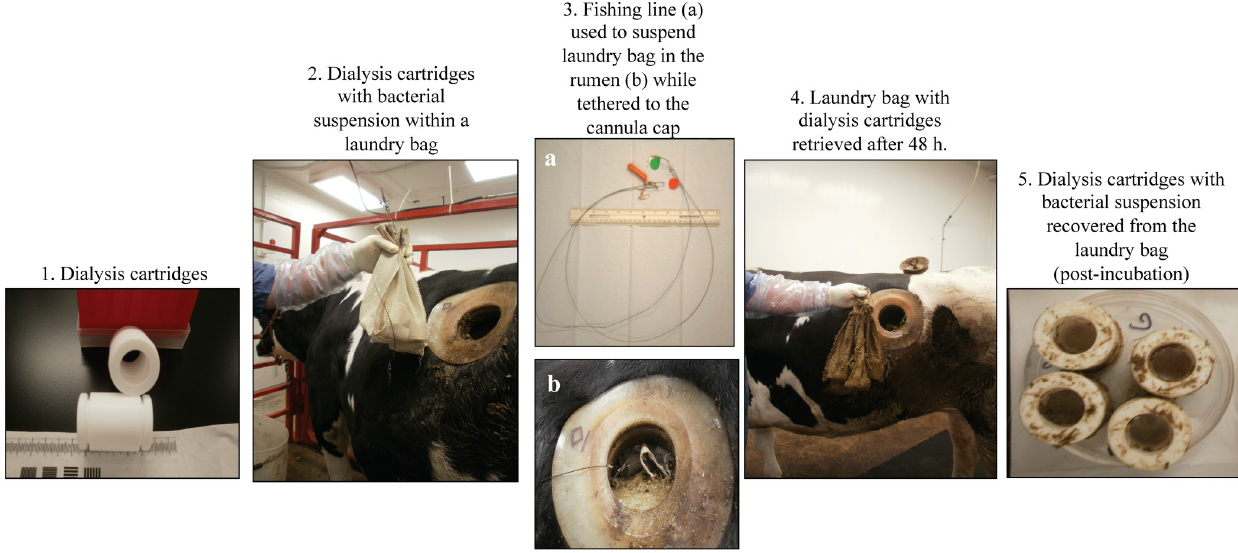
Fig 1. Materials and method used to introduce and retrieve bacteria from the rumen of a fistulated cow allowing reuse of the animal.